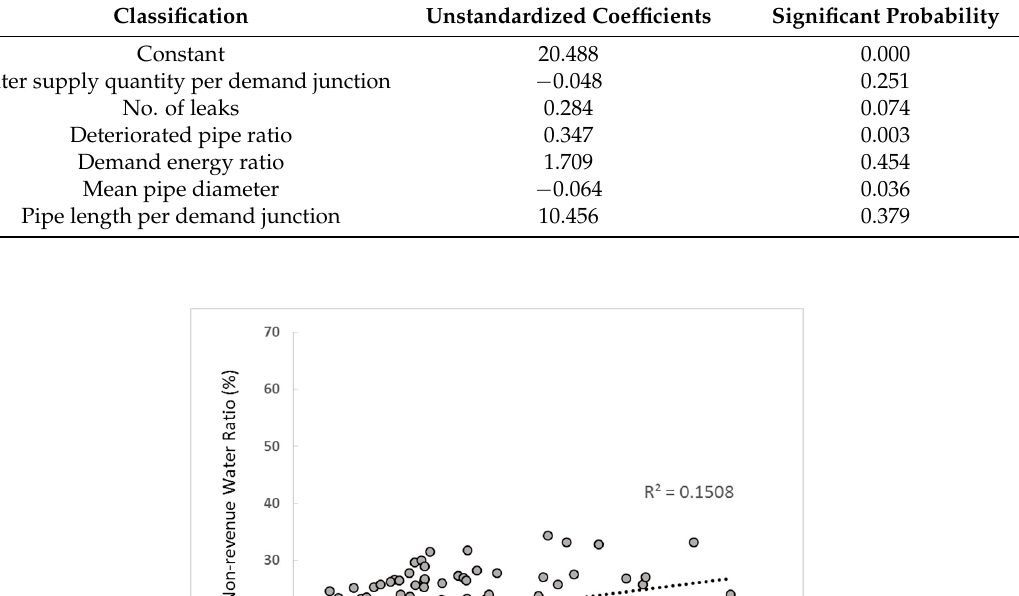
Table 4. Results of Multiple Regression Analysis.